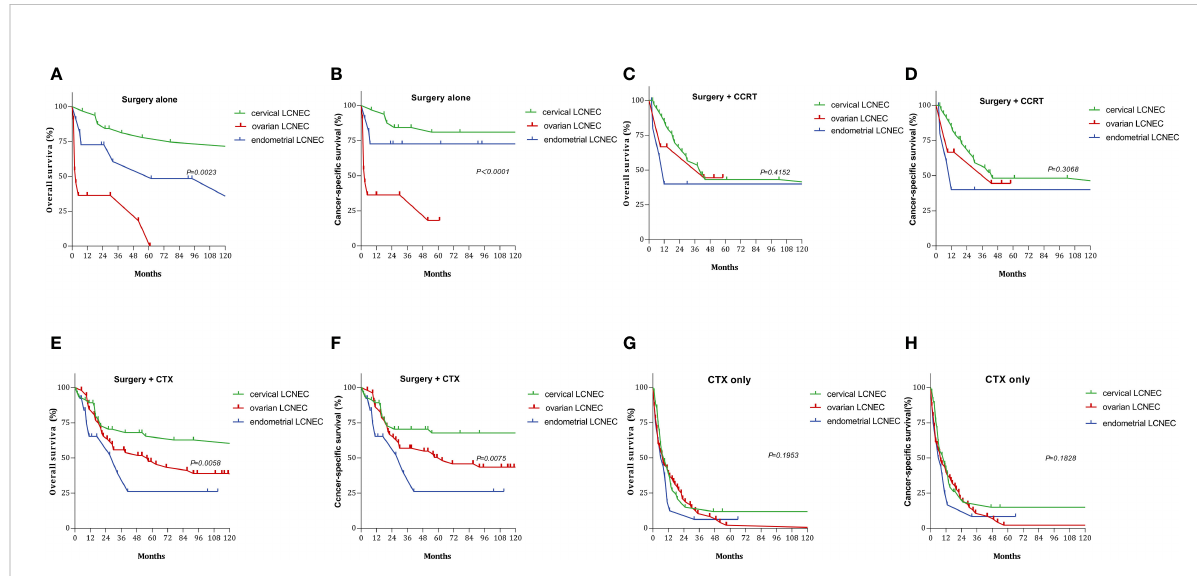
FIGURE 5 Survival curves for gynecologic LCNEC patients with different treatments: (A) overall survival (OS) in surgery alone with gynecologic LCNEC; (B cancer- speci fi c survival (CSS) in surgery alone with gynecologic LCNEC; (C) overall survival (OS) in survery+CCRT with gynecologic LCNEC; (D) cancer-speci fi c survival (CSS) in survery+CCRT with gynecologic LCNEC; (E) overall survival (OS) in surgery+CTX with gynecologic LCNEC (F) cancer-speci fi c survival (CSS) in surgery+CTX with gynecologic LCNEC; (G) overall survival (OS) in CTX only with gynecologic LCNEC (H) cancer-speci fi c survival (CSS) in CTX only with gynecologic